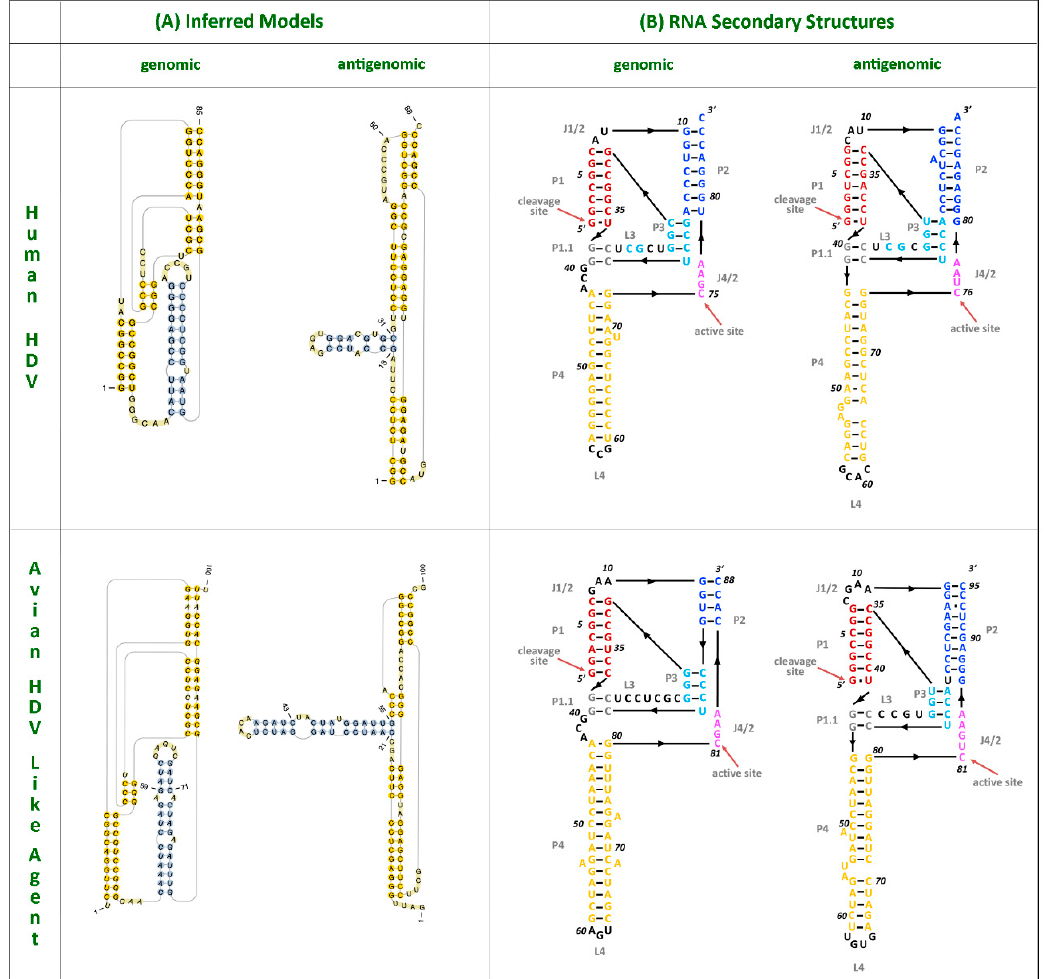
Figure 3. HDV ribozymes. ( A ) Secondary structures of the genomic and antigenomic ribozymes inferred using the TT2NE algorithm. The HDV ribozyme models were used as reference to screen for the ribozyme sequences in the avian HDV-like genome sequence. ( B ) Re-drawn secondary structures of the genomic and antigenomic ribozymes based on the secondary structures shown in the review by Webb and Luptak (21).